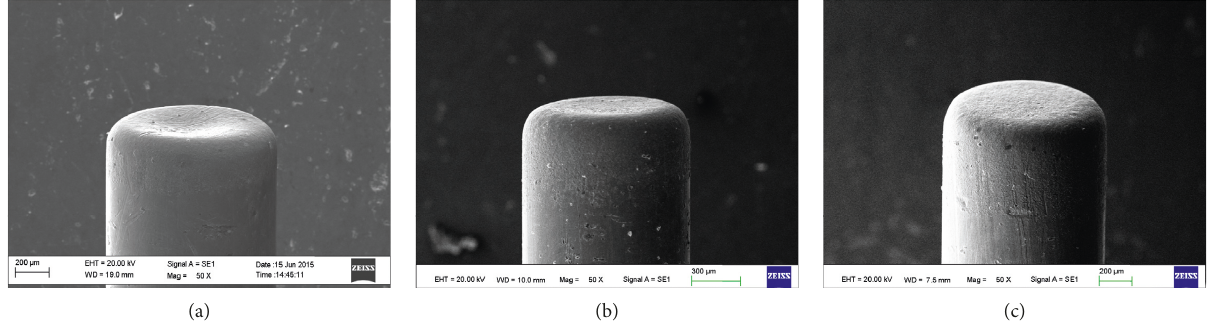
Figure 11: Electrode shape change with the increasing duration of the pulse-on time (no. 5 of Table 1). (a) 1 μ s. (b) 5 μ s. (c) 10 μ